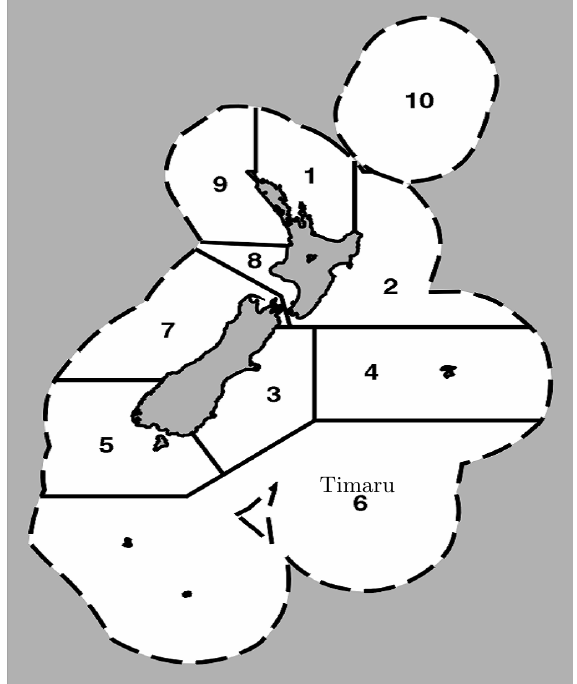
Figure 1: Exclusive Economic Zone of New